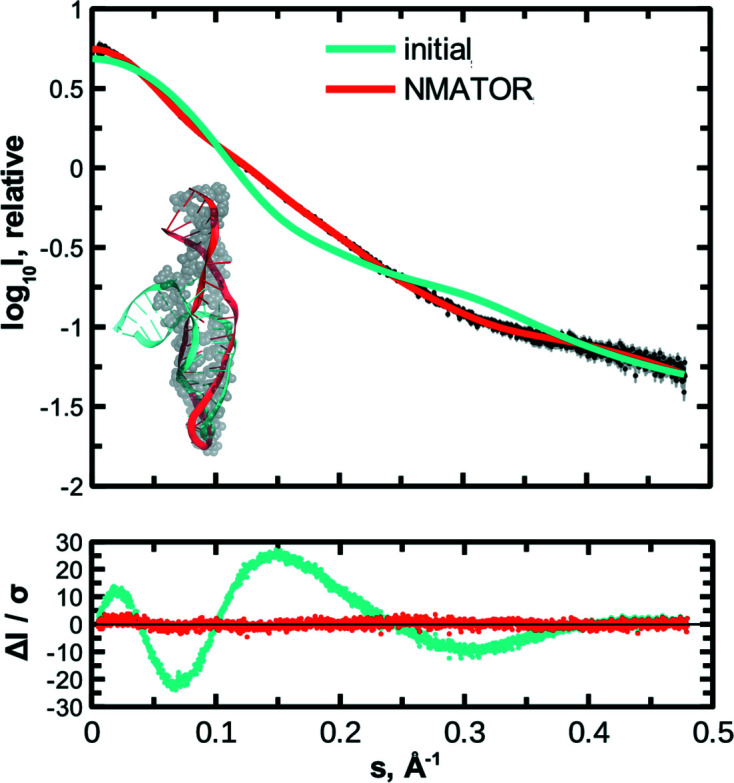

NMATOR models conformational changes in RNA structures to fit SAS data, while preserving bond lengths. Both the initial and target models were obtained from the solution NMR ensemble of U65 Box H/ACA snoRNA (35 nt; PDB ID 2pcv; Jin et al., 2007 ▸). The target model is shown as grey spheres in the bottom-left inset, with the initial model superimposed in cyan. SAXS data were simulated from the target model with IMSIM. The conformational differences between the initial and target models are detected as a poor fit between the IMSIM-simulated SAXS data from the target and the scattering data computed by CRYSOL from the initial model (statistics are summarized in Table 1 ▸). The NMATOR model (red) recapitulated the unbending of the short helix, resulting in a better correspondence to the target model and a much better fit to the simulated data. The residuals are shown in the bottom panel.